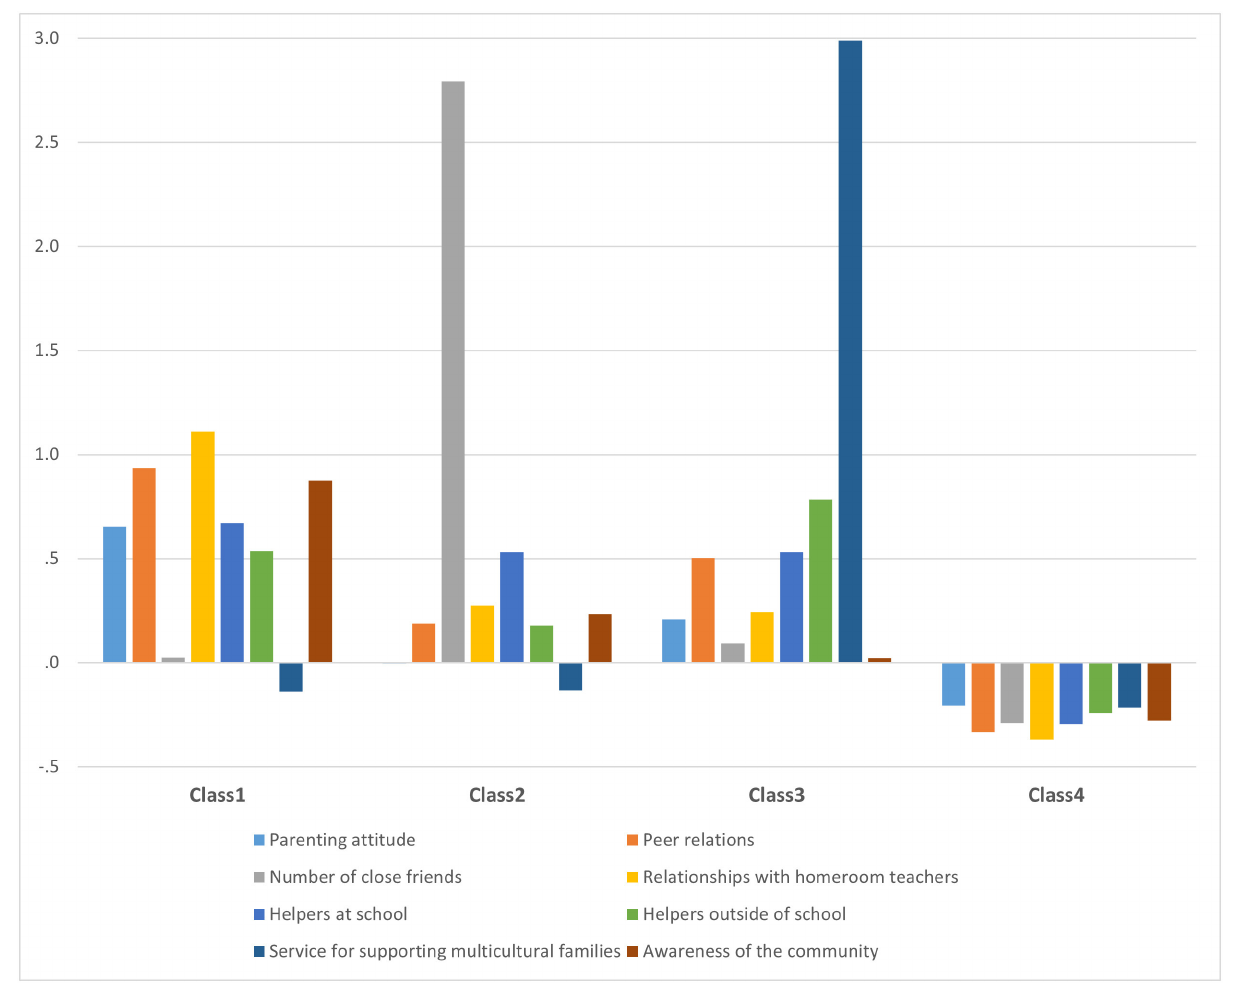
overall social capital (24.9%), average social capital (65.7%),